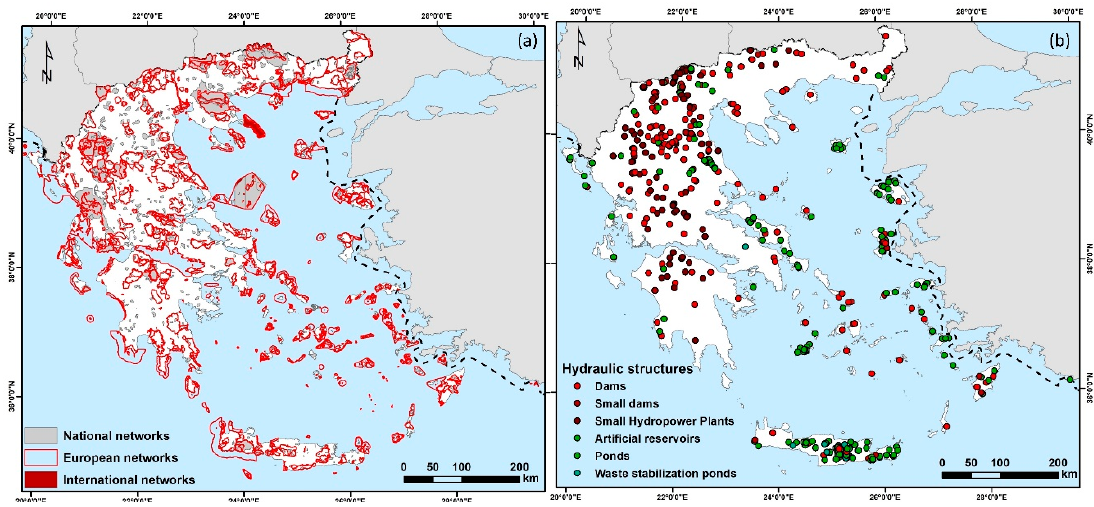
Figure 2. ( a ) Protected areas and ( b ) hydraulic structures in rivers, of Greece.